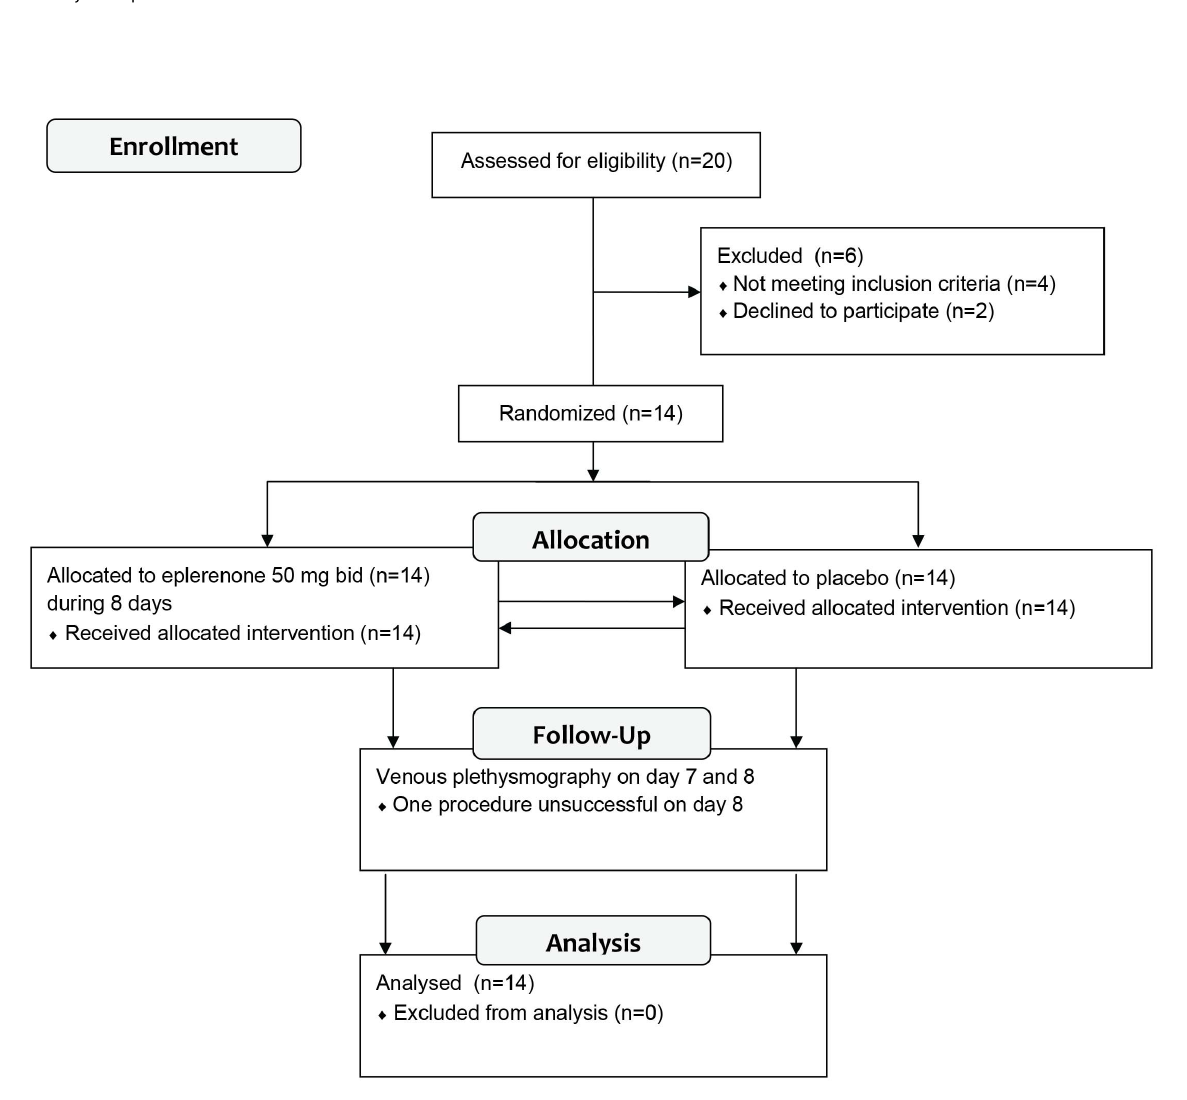
Figure 2. Consort 2010 flow diagram. doi:10.1371/journal.pone.0111248.g002 PLOS ONE |